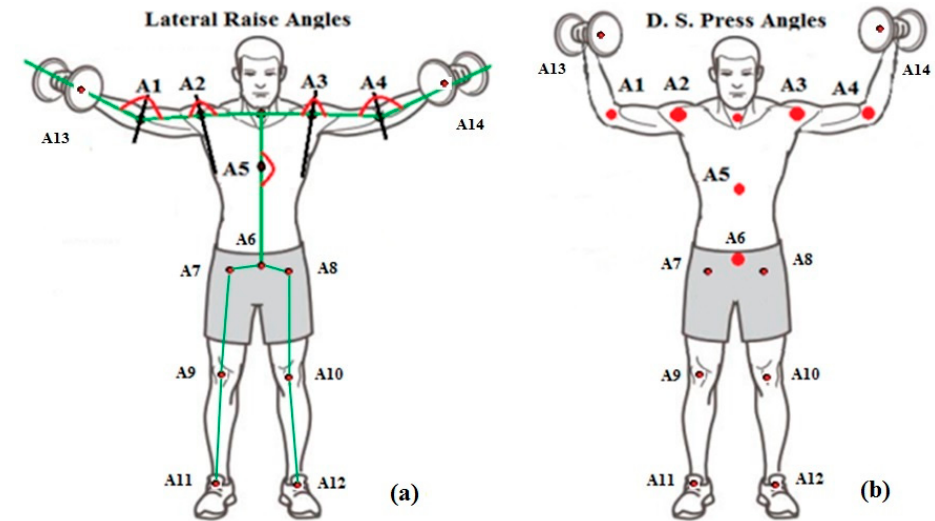
Figure 3. Designed movement models: ( a ) lateral raise (LR) model; ( b ) dumbbell shoulder press (DSP) model.